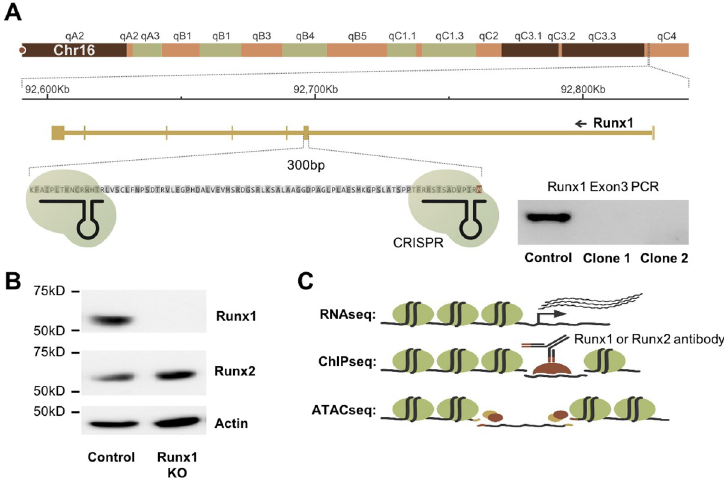
Fig 1. Generation and Characterization of Runx1KO Cells. A) Diagram of the Runx1 exon 3 region targeted for deletion using CRISPR-Cas9 and confirmation of deletion by PCR. B) Western blot showing that Runx1KO cells lack Runx1 protein but contain Runx2. C) Schematic of genomic analyses utilized to characterize Runx1KO cells.